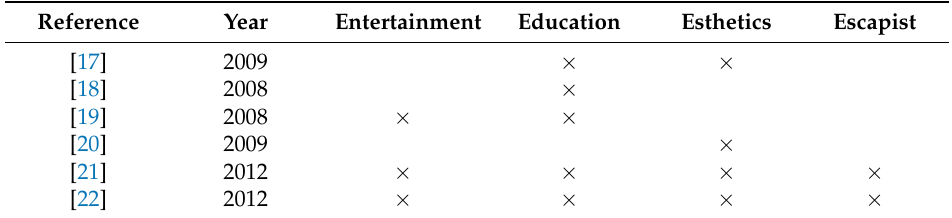
Table 2. Indicators of 4Es in literature with regard to wine tourists (adapted from [21], with permission from Quadri-Felitti & Fiore, 2012).